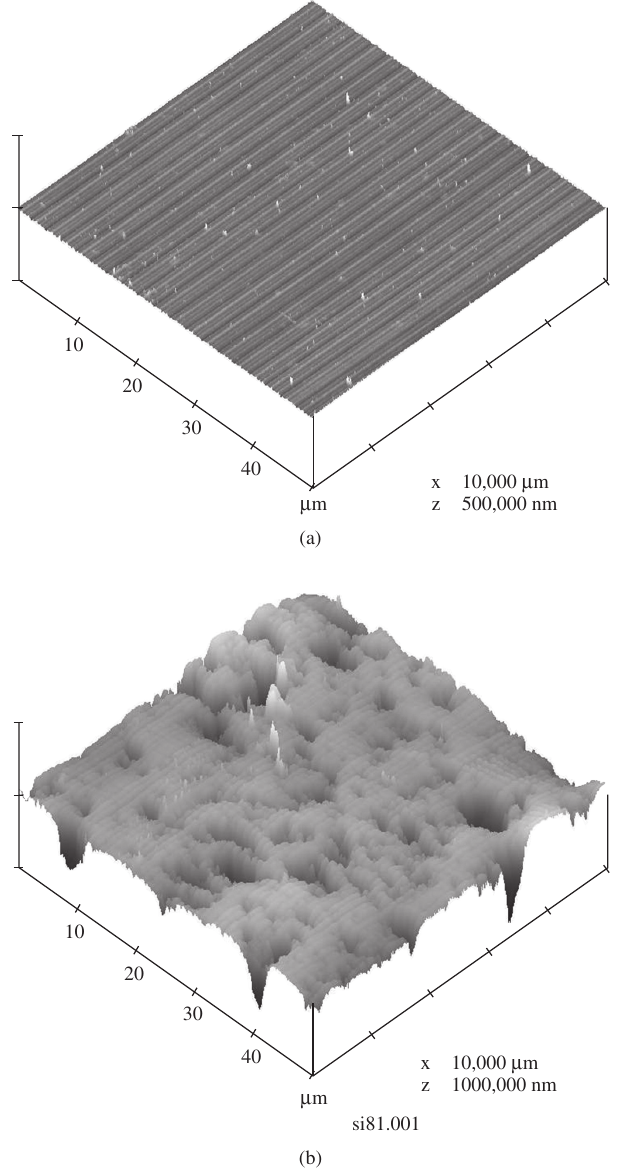
Figure 2. Typical three-dimensional surface finish of the single-point diamond turned specimen obtained by atomic force microscope. The surface finish is smooth and damage-free. a) The cut grooves can be clearly seen, regularly spaced and running parallel with cutting direction which confirms the ab- sence of chatter vibration; b) Examination of the machined surface under Figure 4. a) Raman spectra (performed with the 488.0 nm exciting light) of brittle regime shows that microcracks are present. The cutting conditions the silicon sample: a) before machining; b) surface machined in brittle regime; f = 2.5/8.0 µ m rev -1 (respectively) and d = 5 µ m, and the tool has 0.65 mm c and c) surface machined in the ductile nose radius and - 25° rake angle.